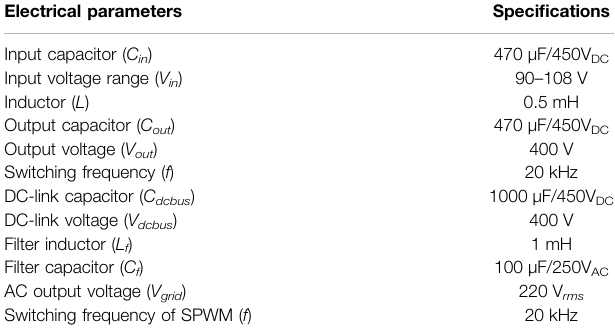
TABLE 4 | The circuit parameters of the boost converter and inverter.